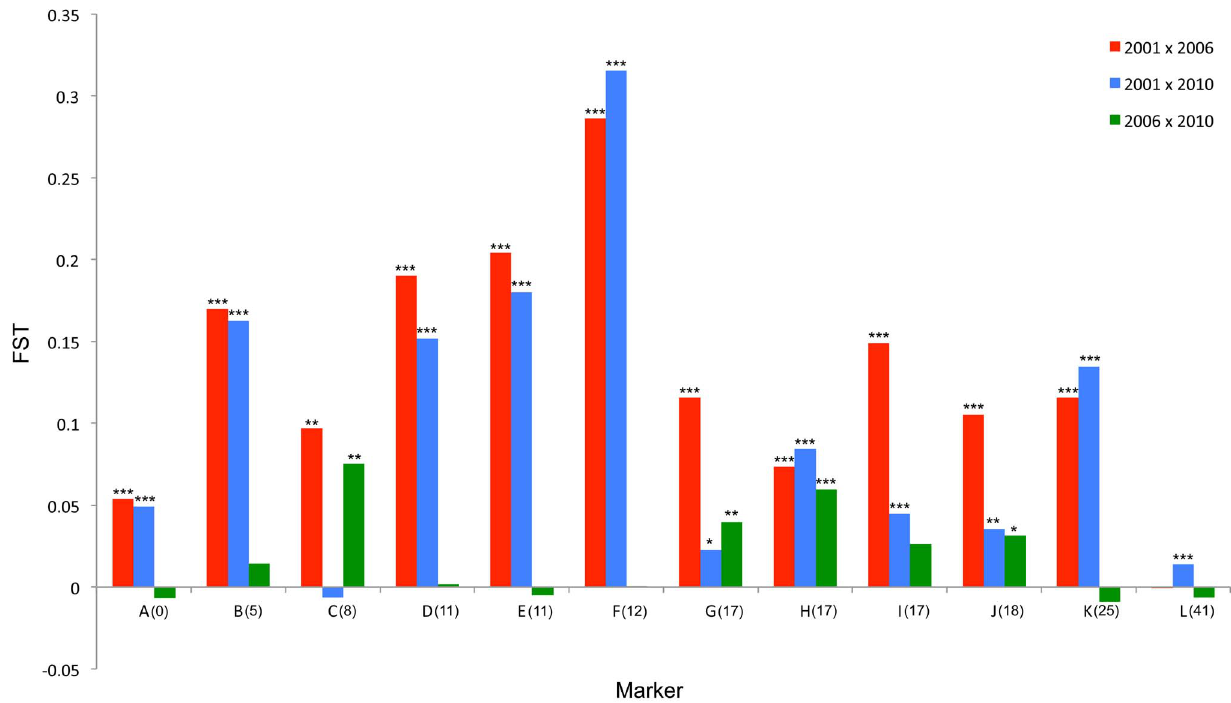
Figure 4. F ST standardized population genetic differentiation between samples from different time points for each locus along the chromosome carrying the suppressor. Blue: 2001–2006; Red: 2001–2010; Green: 2006–2010. Statistically significant deviations from F ST =0 given by *** (p , 0.001), ** (p , 0.01) * (p , 0.05) uncorrected for multiple tests. Depiction of suppressor linkage group given for reference. Position along SLG given in parenthesis on